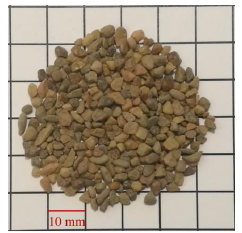
Figure 1. Sample of river gravel.